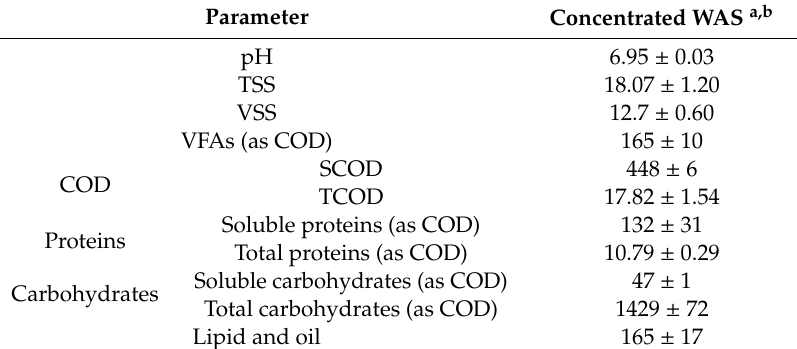
Table 1. The main characteristics of the concentrated WAS.